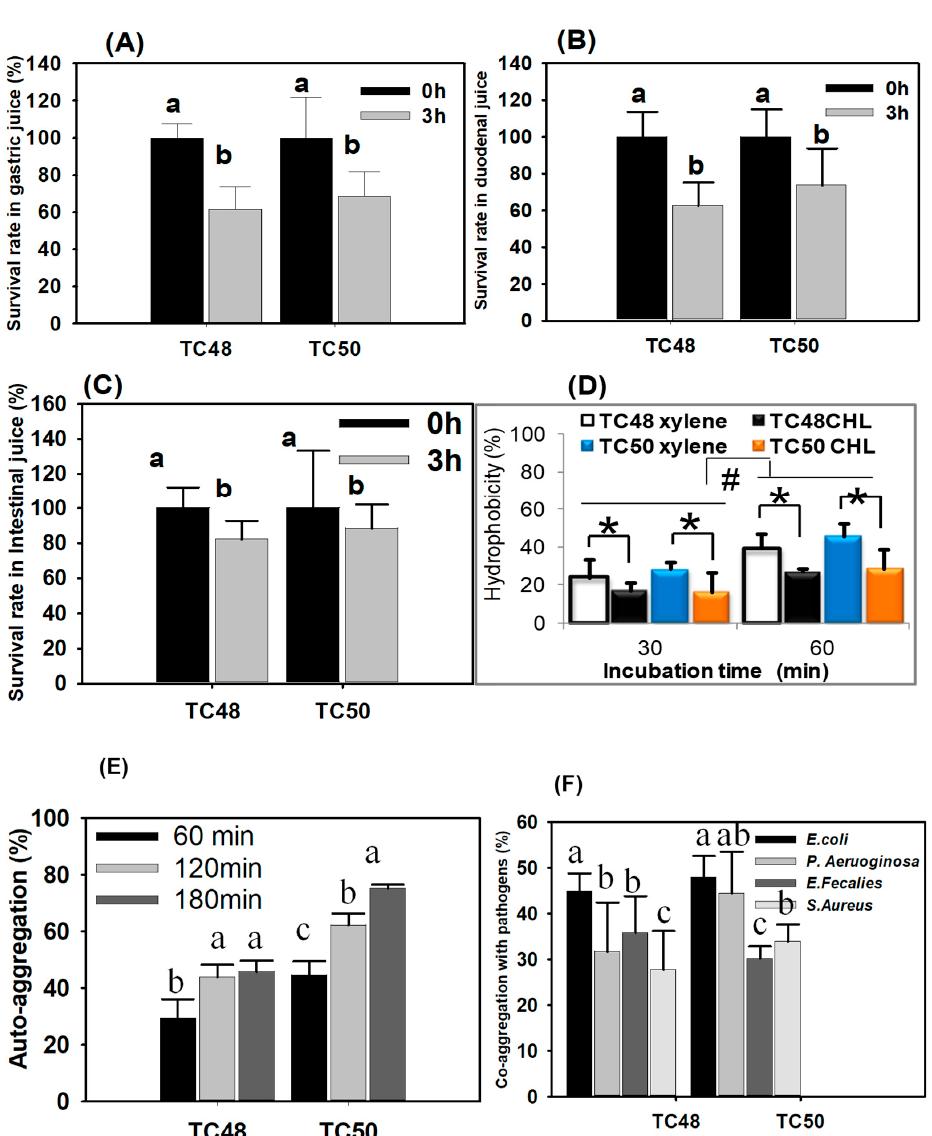
Figure 6. Probiotics feature of TC48 and TC48—in vitro. ( A ) Survival rate of TC48 and TC50 in gastric juice (GJ); ( B ) survival rate of TC48 and TC50 in duodenal juice (DJ); ( C ) survival rate of TC48 and TC50 in intestinal juice (IJ); ( D ) percentages of hydrophobicity for TC48 and TC50; ( E ) percentages of auto-aggregation for TC48 and TC50; ( F ) percentages of co-aggregation for TC48 and TC50 with pathogenic bacteria. Data represent the mean ± STD ( n = 5, p values 0.05). * p < 0.05 significance between xylene and chloroform (CHL) # p < 0.05 indicates significance between 30 min and 60 min. Di ff erent letters a, b, and c within a column indicate significant di ff erences between time; between pathogenic bacteria.